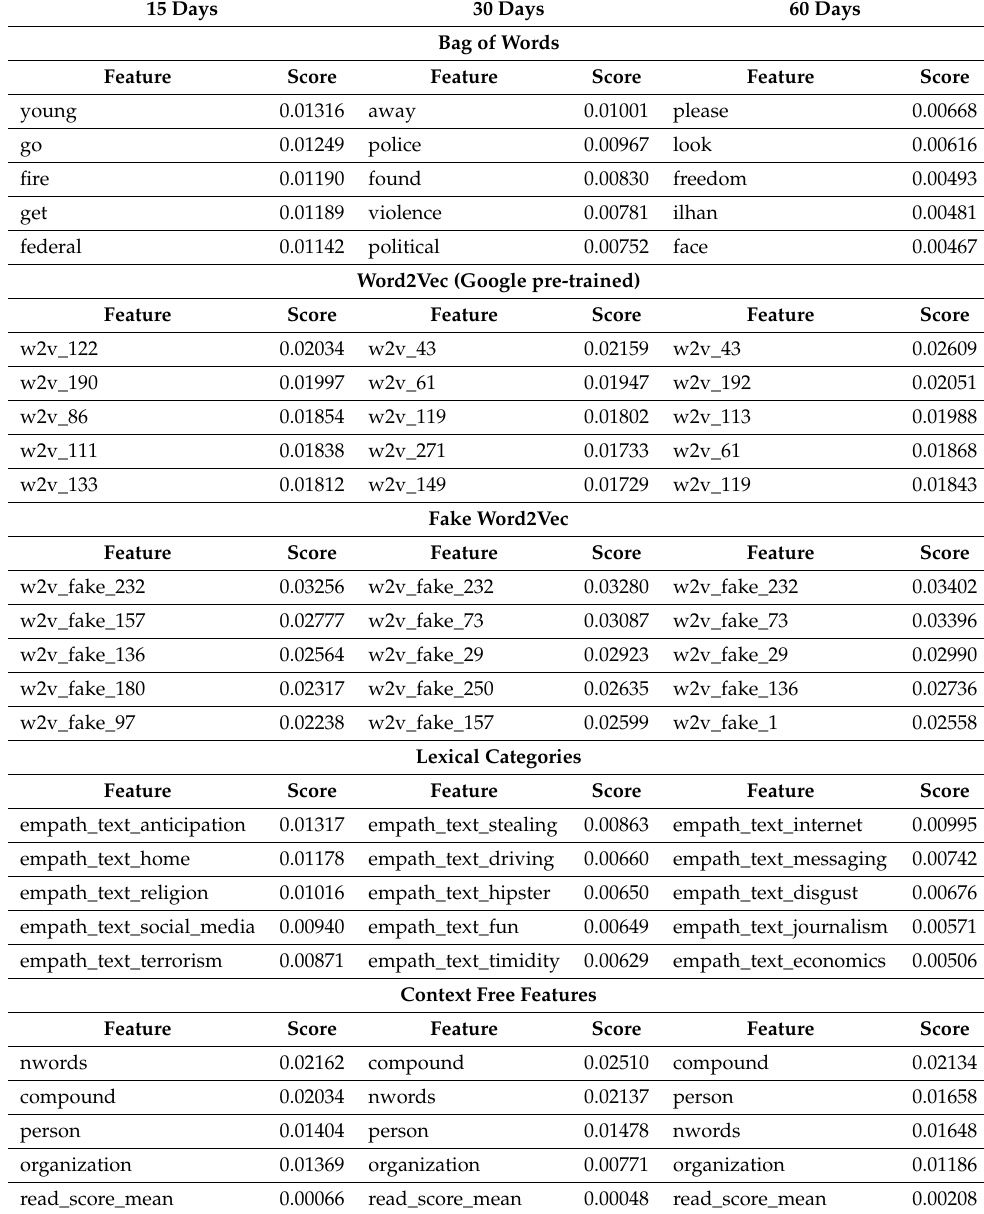
Table 2. Feature importance scores regarding different set of features and three scenarios considered (15-, 30-, and 60-day